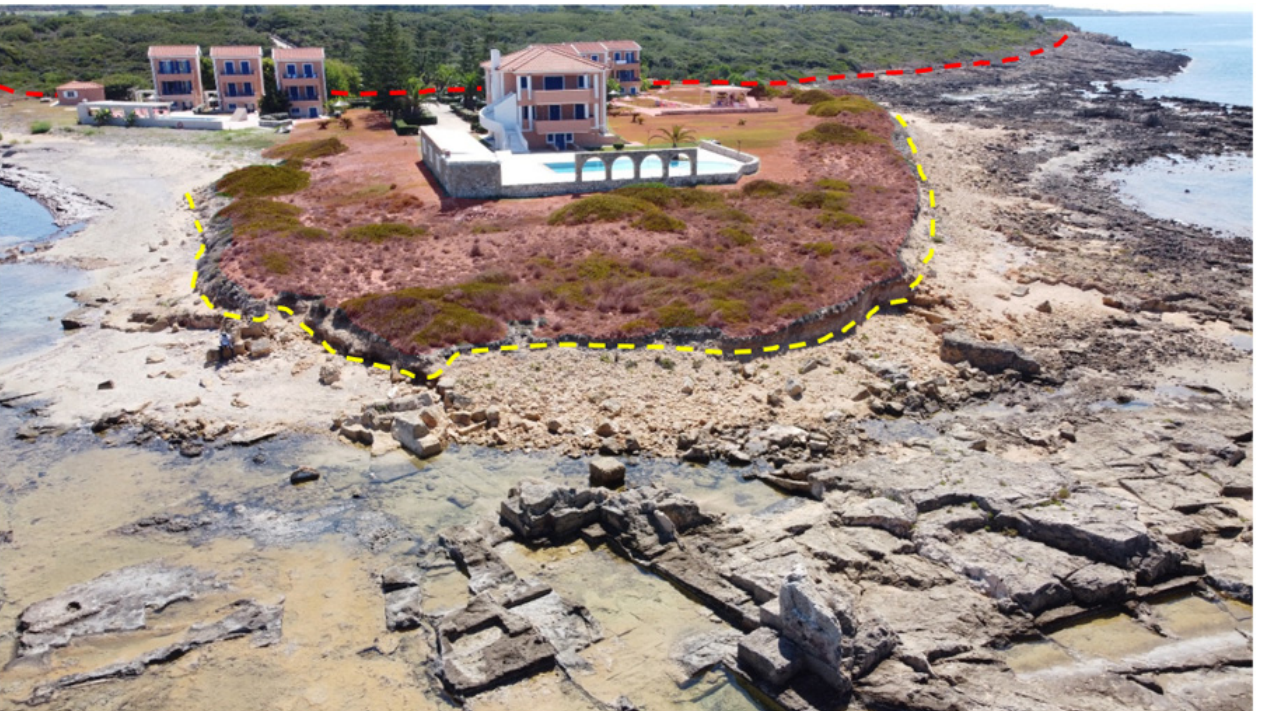
Figure 5. Drone image of the marine terrace VII located at cape Agios Nikolaos (view towards east-northeast). The red dashed line corresponds to the inner edge of the terrace at 4 m while the yellow dashed line corresponds to the base of the modern sea cliff. The elevated palaeosurface is highlighted with transparent red color.